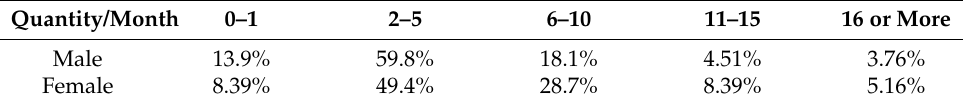
Table 11. Relationship between gender and number of express packages in a month.